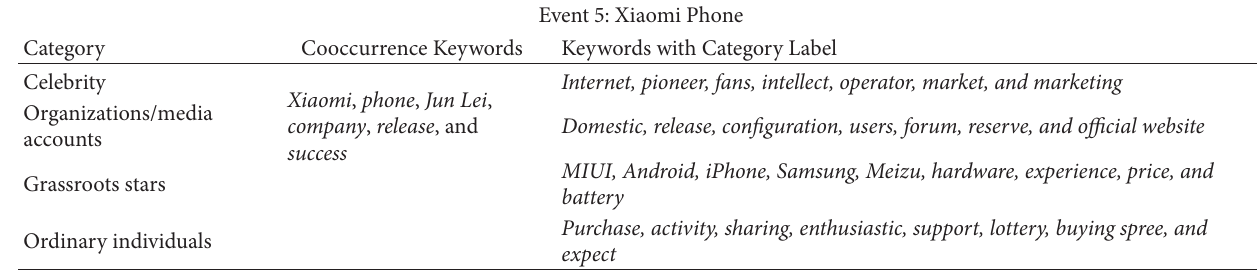
Table 9: Keywords distribution on the event of “Xiaomi Phone.”